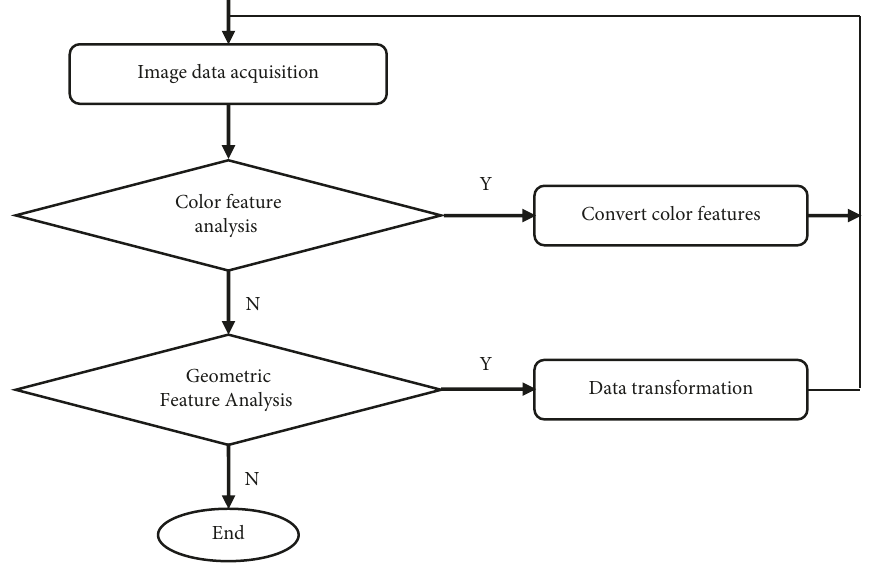
Figure 2: Machine vision signal conversion process.